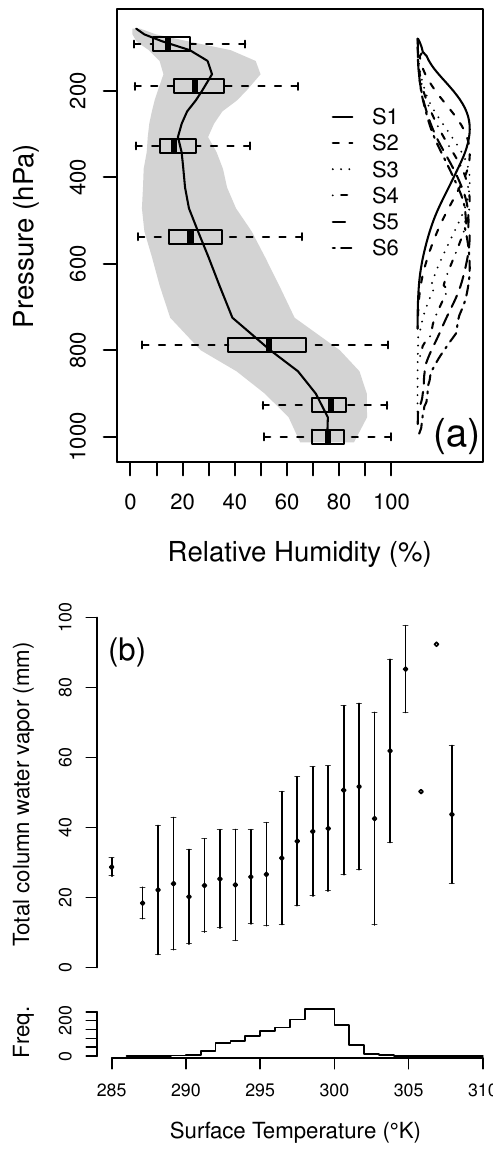
Figure 1. Characteristics of the database. (a) Distribution of total column water vapor (mm) according to the surface temperature (K). The top panel represents the average plus or minus 1 standard devia- tion. The number of observations is represented in the bottom panel. (b) The initial 22-level RH profiles are summarized by their mean (black line) and their standard deviation (grey envelope) and the re- duced seven-layer clustering using box-and-whiskers diagram. For each layer, the box-and-whiskers diagram indicates the median (the central vertical line), and the lower and upper quartiles (left and right edges of the box). The whiskers indicate the lower and up- per limits of the distribution within 1.5 times the interquartile range from the lower and upper quartiles, respectively. The tropical mean normalized weighting functions of SAPHIR are also represented on the side (no scale). S1...S6 refers to SAPHIR channels (see Ta- ble